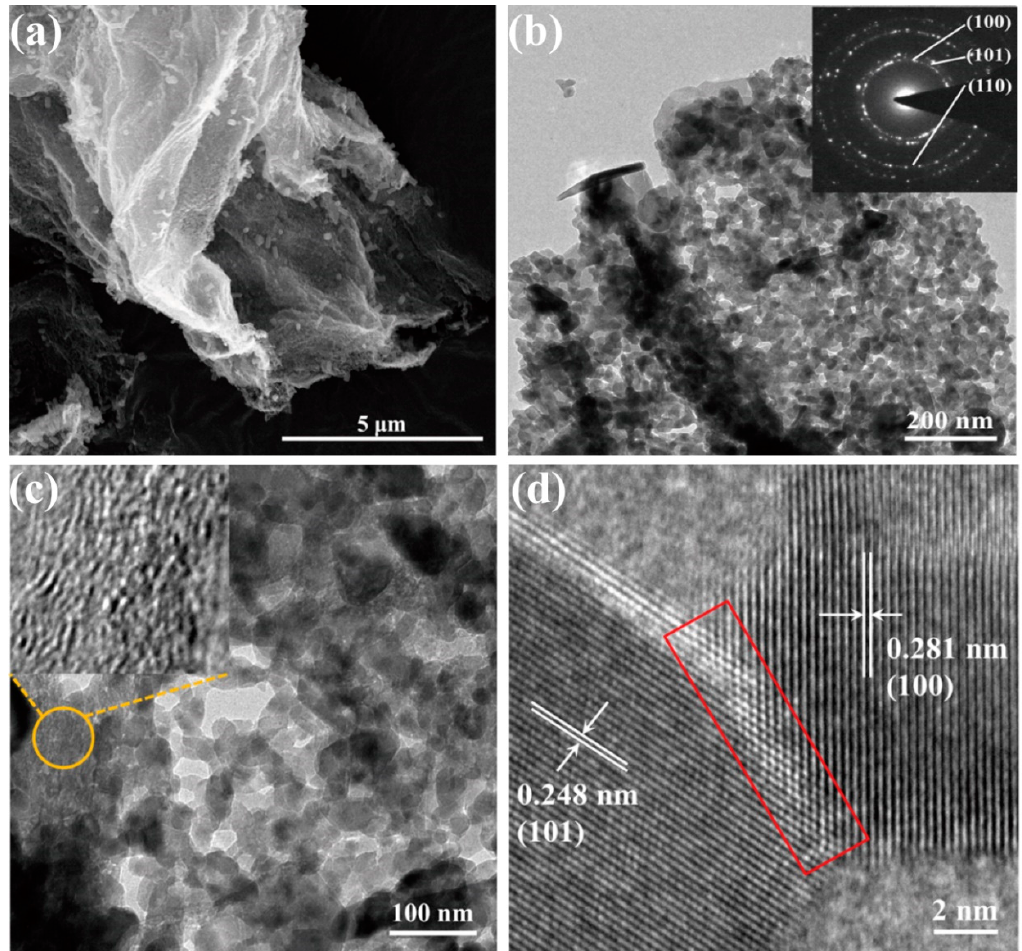
Figure 2. ( a ) The SEM image of ZnO/GO NSs-525; ( b ) TEM image of ZnO/GO NSs-525 and the selected area electron diffraction (SAED) pattern was inset; ( c ) large magnification TEM image of ZnO/GO NSs-525, the inset is an enlarged disordered lattice fringe view of GO in the local area of a HRTEM image; ( d ) HRTEM image of ZnO/GO NSs-525.